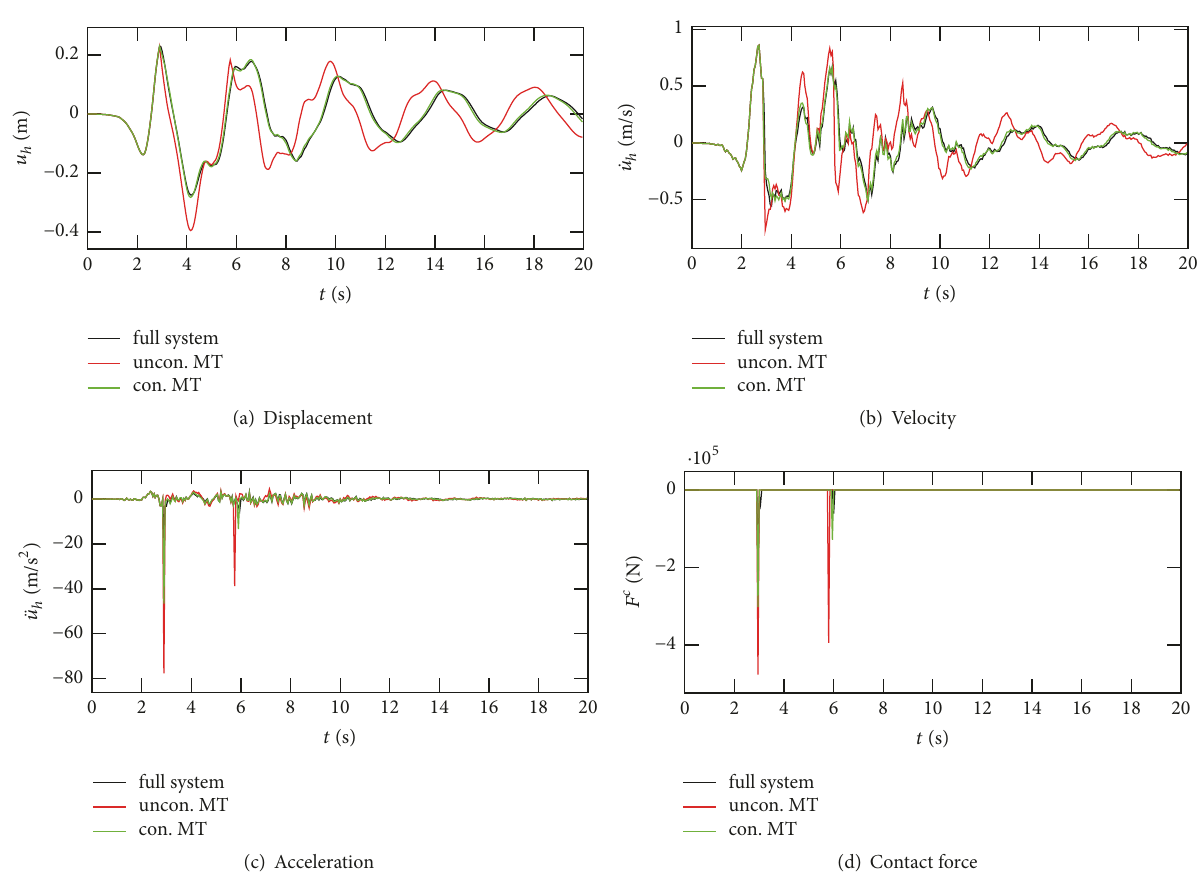
Figure 14: Results for the displacement, the velocity, and the acceleration as well as the contact force under seismic excitation (Bam).